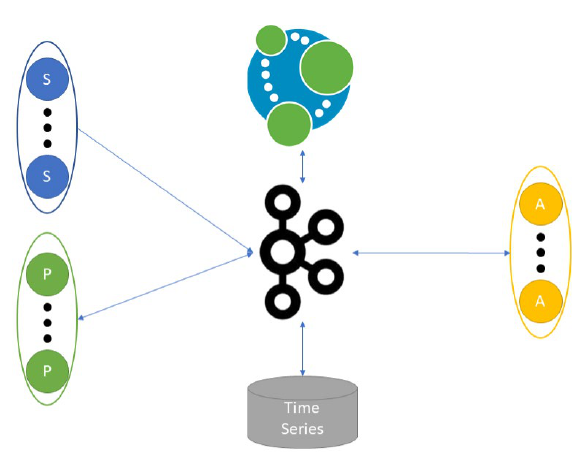
Figure 8. Communication schema between actors involved in data passing: (S)ensors, (P)rocessors and (A)nalysers with Neo4j and a specialised Time Series database